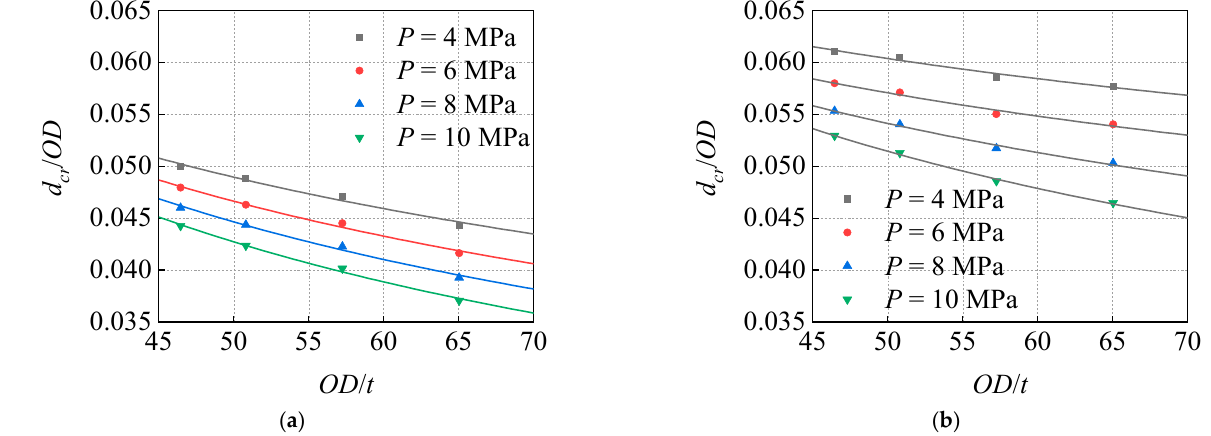
Figure 20. Influence of diameter–thickness ratio on critical dent depths under different pressures: ( a ) R / OD = 0.08, ( b ) R / OD = 0.12.